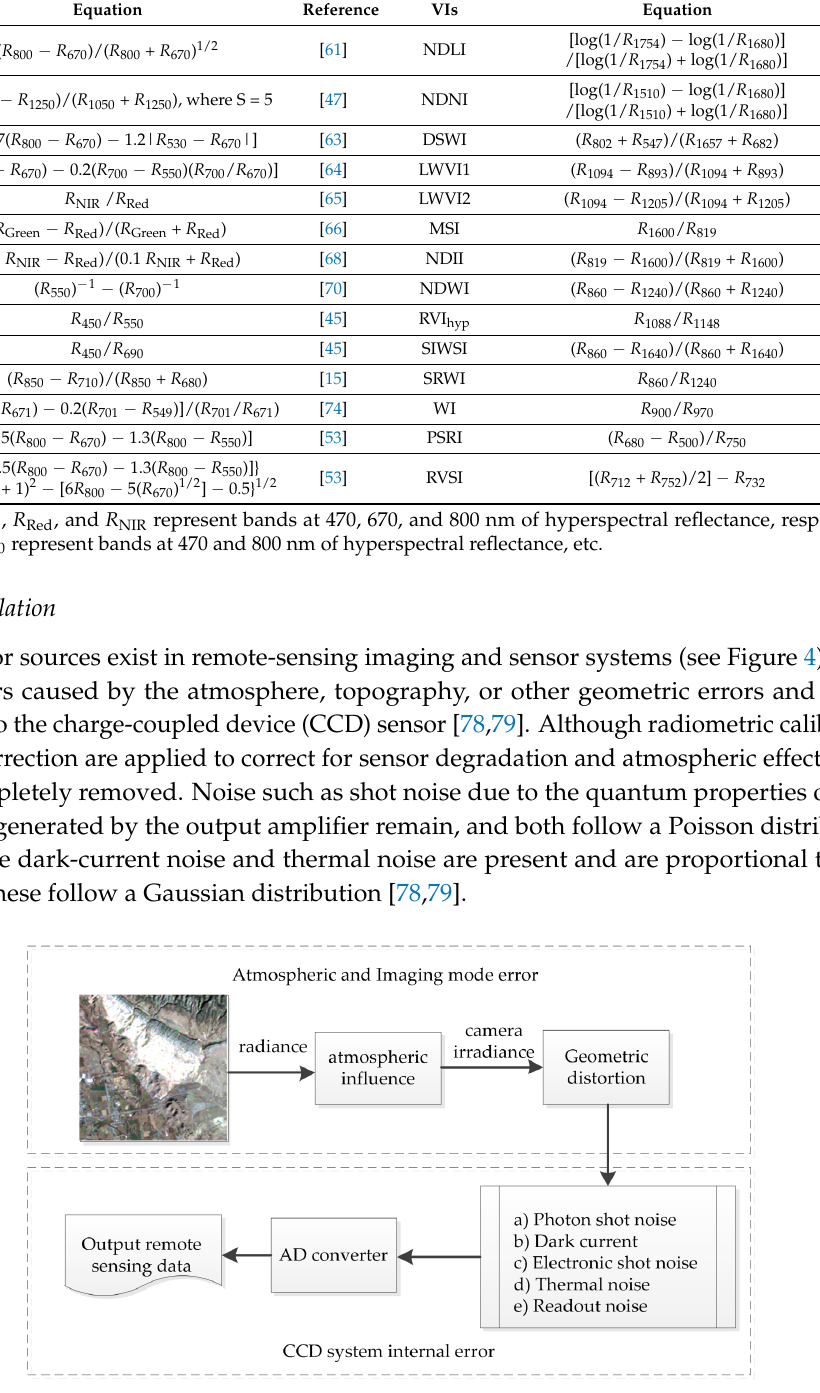
Figure 4. Remote-sensing imaging process and noise sources in a charge-coupled device (CCD) system.